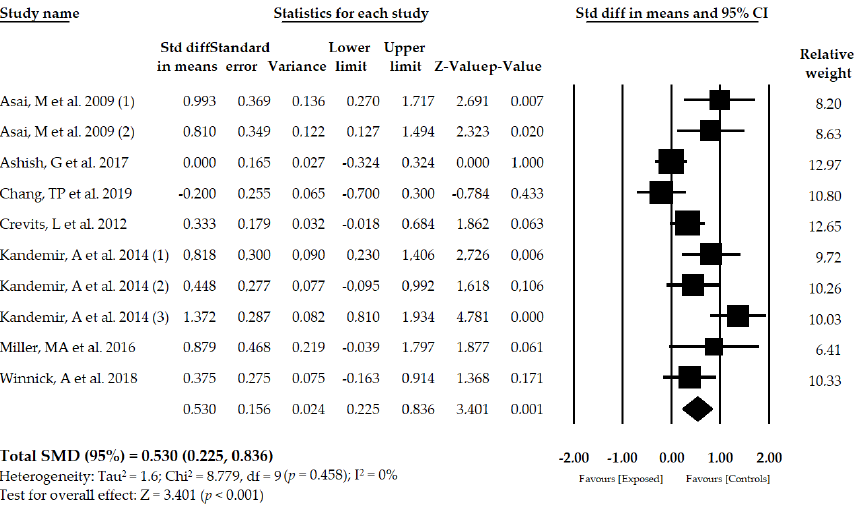
Figure 3. Forest plot for the perception of visual verticality, assessed with the SVV test, in patients with primary headache disorders .